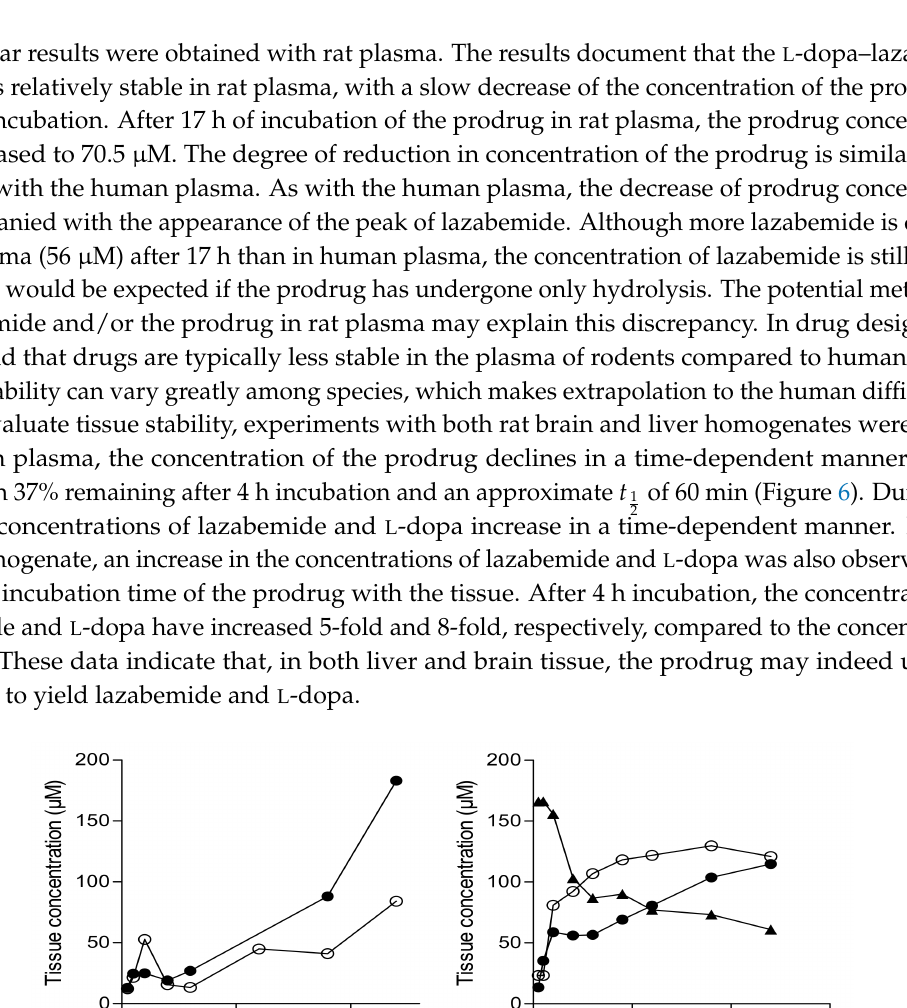
Figure 5. The metabolic stability of the L -dopa–lazabemide prodrug in human and rat plasma. Key: lazabemide (open circles); prodrug (filled circles). Values are given as mean ( µ M) ± standard deviation of triplicate determinations.